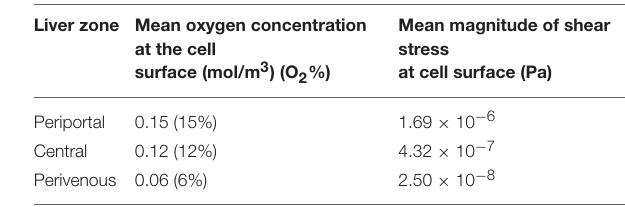
TABLE 1 | Mean oxygen concentration and magnitude of shear stress at the cell surface for each liver zone, periportal (cells raised by 7mm), central (cells raised by 4mm), and perivenous (cells raised by 0mm i.e., cultured at the base of the